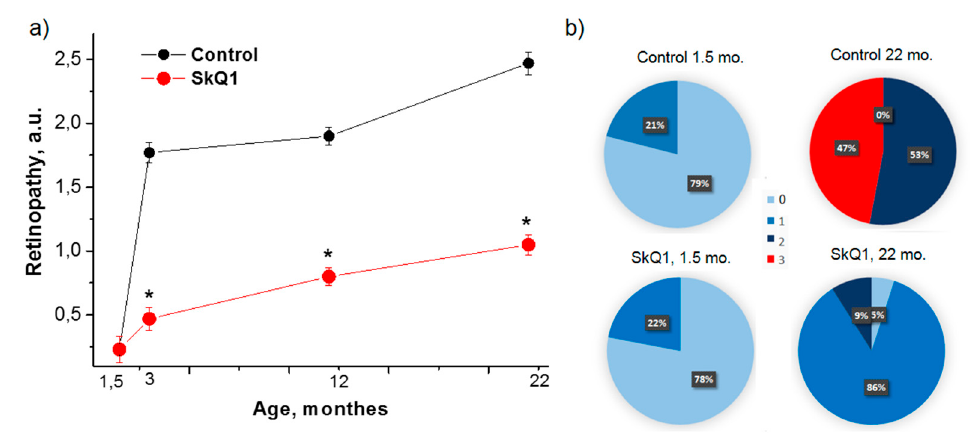
Figure 2. SkQ1 inhibits retinopathy development in OXYS rats. The age-dependent changes in severity of retinopathy in control and SkQ1 treated OXYS rats; the treatment (250 nmol / [kg body weight] daily) was started when the rats were 1.5 months old ( a ). Each group corresponds to 30 eyes of 15 animals. The data are presented as mean ± SE of a.u. corresponding to the stages of retinopathy. Stages of retinopathy in control and SkQ1-treated OXYS rats at the age of 1.5 and 22 months ( b ). Data are presented as percentage of eyes with stage 0, 1, 2, or 3 of retinopathy.